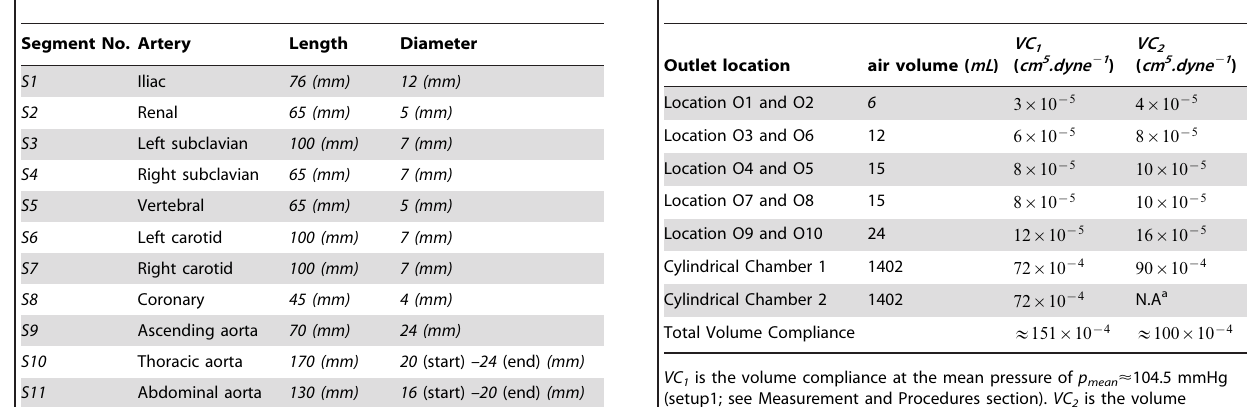
Table 1. Geometrical properties of the aortic mold.